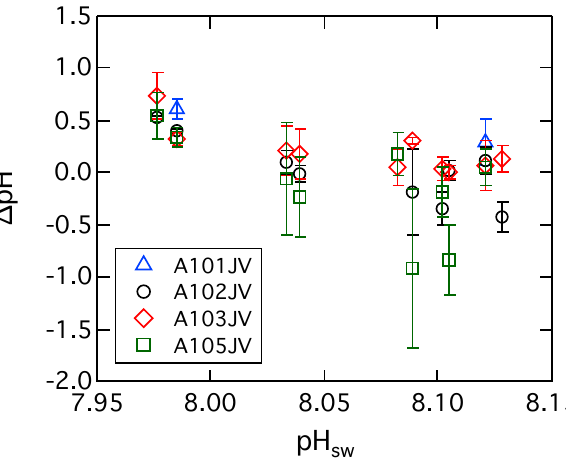
Figure 7. The calculated pH discrepancy ( (cid:49) pH = pH shell − pH sw ) shows a statistically significant negative relationship to pH sw ( R 2 = 0.35; p value ≤ 0.001). The negative correlation supports the argument that A. islandica regulate their EPF pH for calcification. The shell calcification pH (pH shell ) were calculated based on in situ water temperature α = 1.0272 (Klochko et al.,